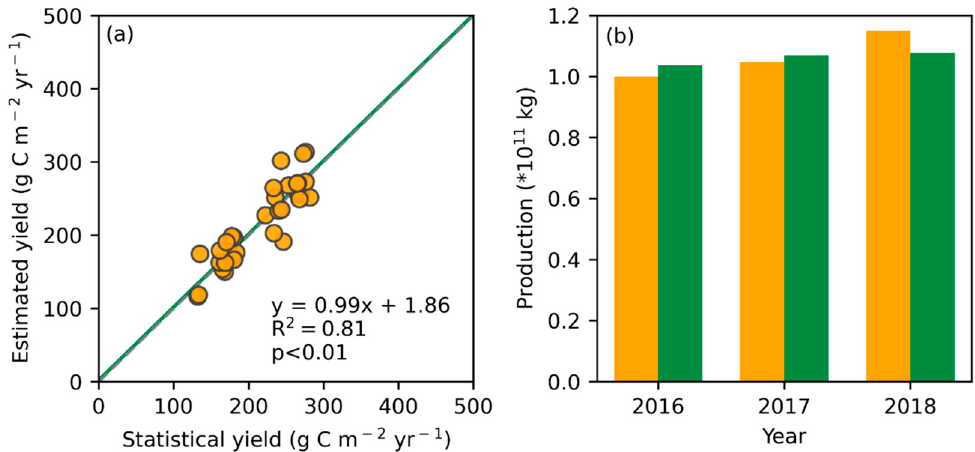
Figure 8. Statistical and estimated yield and total production from 2016 to 2018. ( a ) Statistical and estimated yield in all investigated 11 provinces, the green solid line is the regression line, and the grey short-dashed line is the 1:1 line. ( b ) Statistical and estimated total production of the whole study area, the yellow and green bars are estimated and statistical production, respectively.